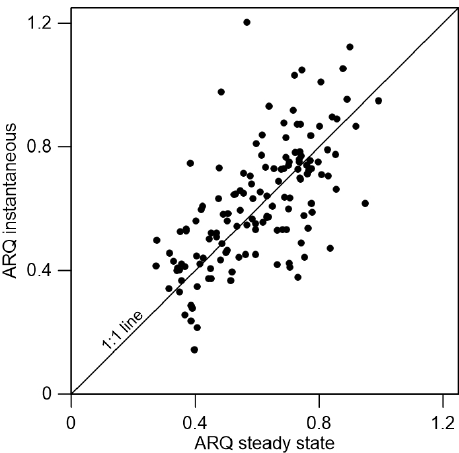
Figure 2. Scatter plot of instantaneous ARQ (ratio of CO 2 efflux / O 2 influx for tree stems) measured in stem cham- bers after incubation of 30min to a few hours and steady-state ARQ measured in the same experiment with typically 2 days of incubation ( n =